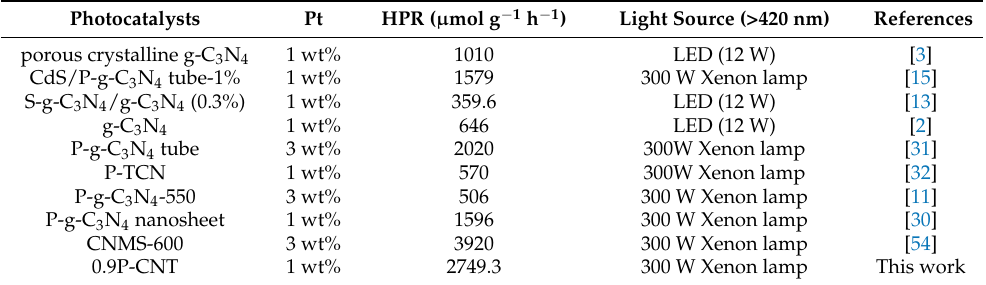
Figure 9. The photocatalytic hydrogen production ( a ) and HPR ( b ) of the CNB, 0.3P-CNT, 0.6P-CNT, 0.9P-CNT, 1.2P-CNT, 1.5P-CNT, and CNT samples. Table 2. The photocatalytic hydrogen production performance on the various reported photocatalysts.